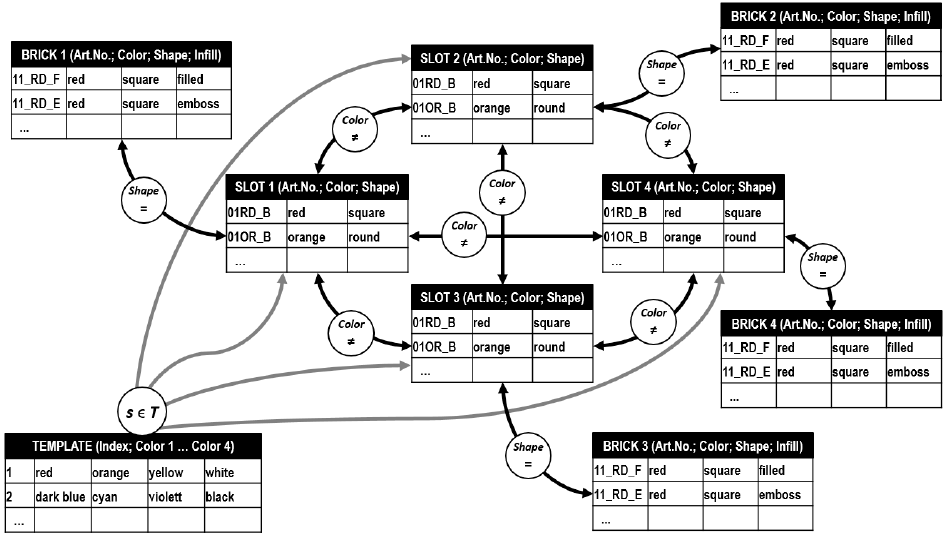
Figure 4. Constraint network for the sorting box configuration problem.